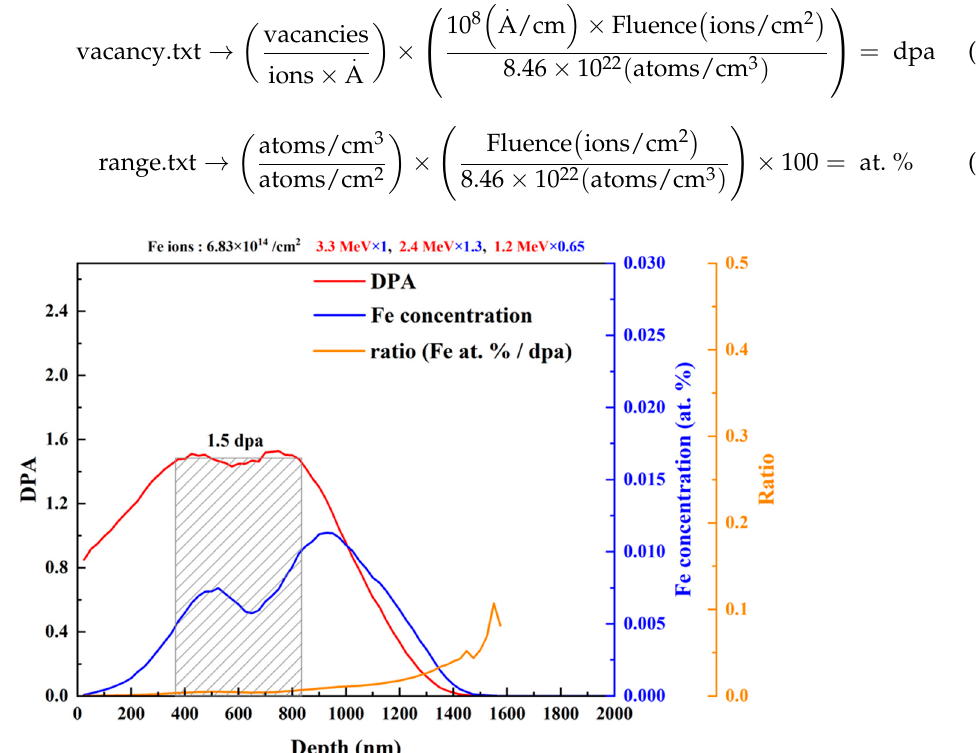
Figure 2. Depth distribution of displacement damage with plateau showed as the shaded area indi- cated for irradiation with 1.2 MeV/4.44 × 10 14 /cm 2 , 2.4 MeV/8.88 × 10 14 /cm 2 , and 3.3 MeV/6.83 × 10 14 /cm 2 Fe + ion beams according to the simulation in